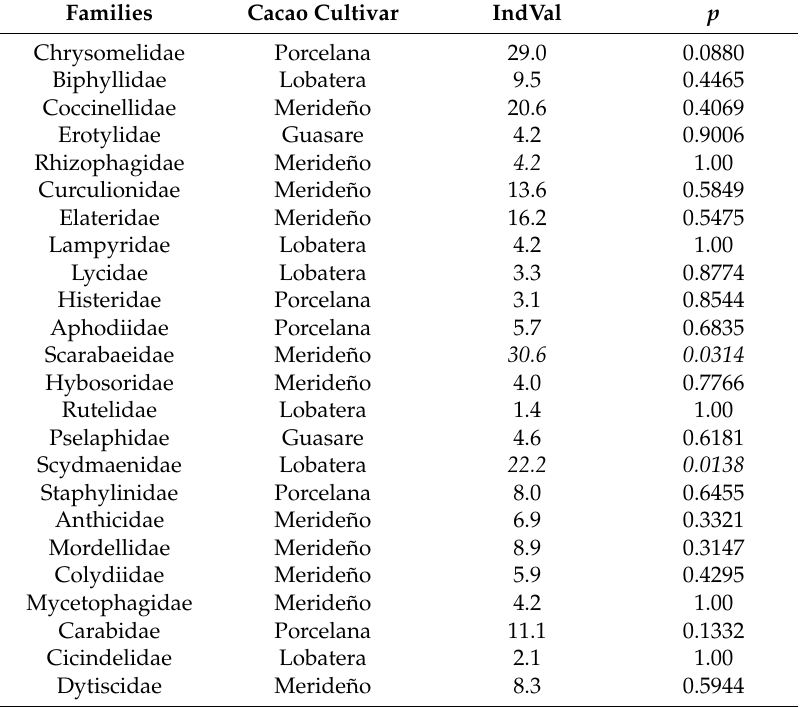
Table 7. Results obtained from the indicator species analysis in Coleoptera families associated to every cacao cultivar in the study. In italics when significant ( p < 0.05). IndVal = indicator